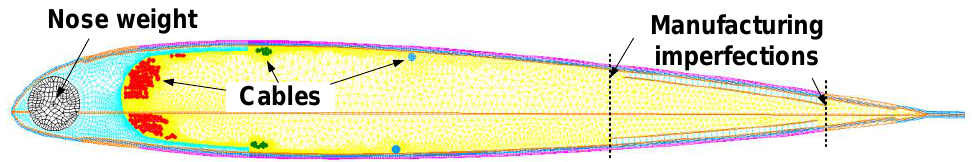
Figure 17. Design parameters used for the sensitivity study of blade section U6 (0.9125 R ).